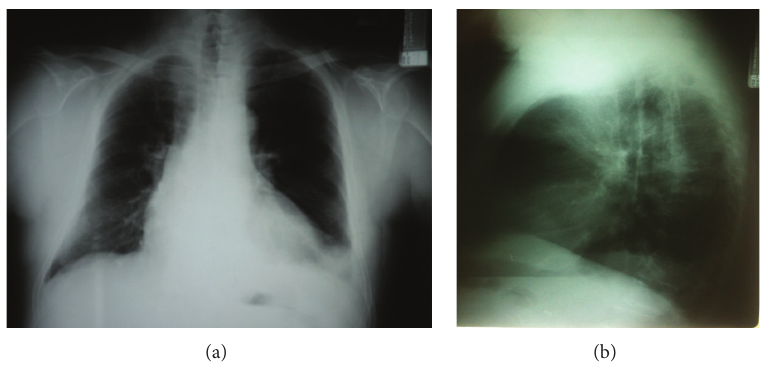
Figure 1: Chest X-ray of the patient on admission in the nephrology